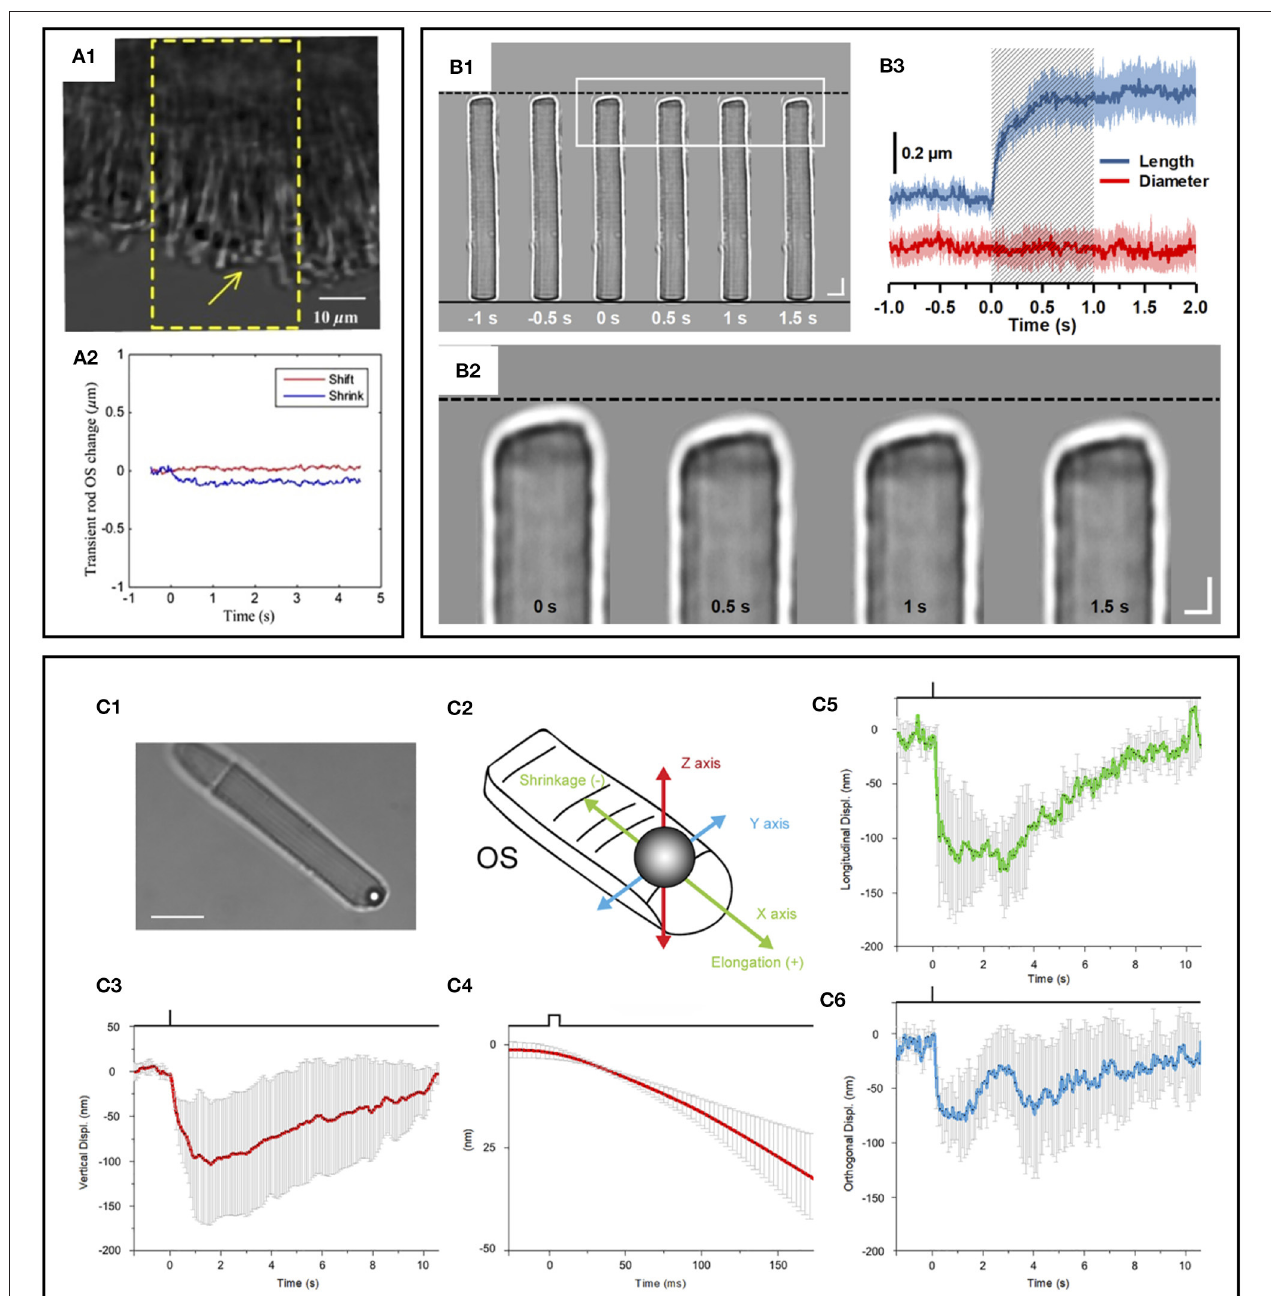
FIGURE 7 | Photoreceptor outer segment (OS) shrinkage due to light stimulus. (A1) Stimulus-evoked mouse rod OS movement. The yellow window indicates the stimulation area. (A2) OS changes of a mouse rod photoreceptor. In the center of the stimulation region, the length of the OS shrunk, while in the peripheral region, the OS swung toward the center of the stimulation area in the plane perpendicular to the incident stimulus light. Reprinted with permission from Zhao et al. (88). (B1) Representative light microscopic images of an isolated frog rod OS acquired with an interval of 0.5s. To better show the light-evoked OS shrinkage, the base of the rod OS in each image is aligned horizontally as shown by the black solid line at the bottom. The black-dashed line at the top represents the position of the rod OS tip at time − 1s. Scale bars (in white) represent 5 µ m. (B2) Enlarged picture of the white rectangle in (B1) . Scale bars (in white) represent 2 µ m. (B3) Time course of the averaged rod OS shrinkage in both length and diameter acquired from eight different rod OSs. Colored areas accompanying the curves represent the standard deviations. Shaded area indicates the 1-second stimulation period. Reprinted with permission from Lu et al. (82). (C) Mechanical response of an X. laevis rod to light flashes. The position of a bead sealed against the tip of the rod OS is monitored with optical tweezers. Following a bright flash of 491nm, equivalent to about 10 4 photoisomerization [R*], a transient shrinkage is observed. (C1) Bright-field infra-red image, showing a trapped bead in contact with the tip of the rod OS (scale